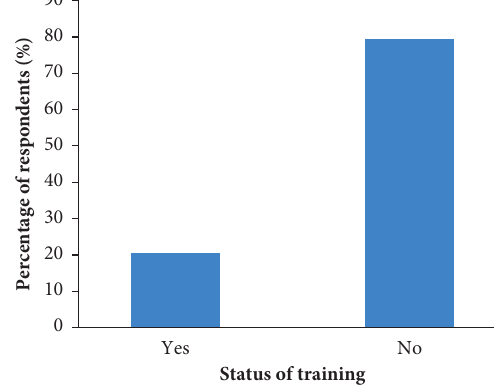
Figure 7: Status of training to